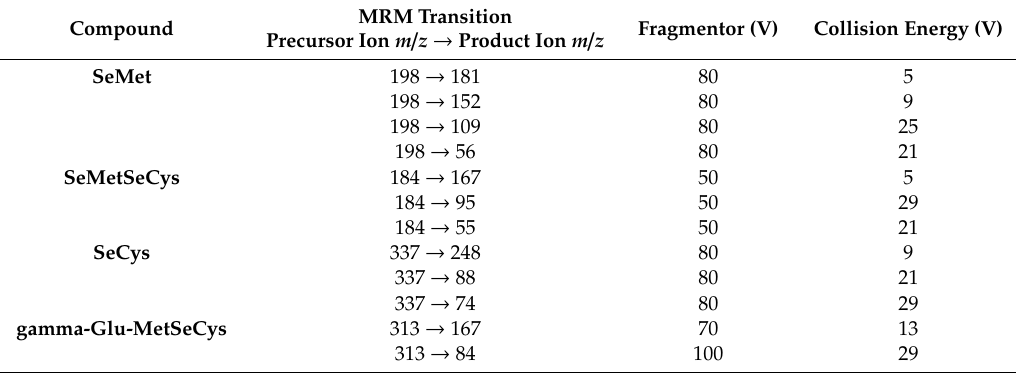
Table 2. Optimized multiple reaction monitoring (MRM) QqQ-MS / MS working parameters for selenium